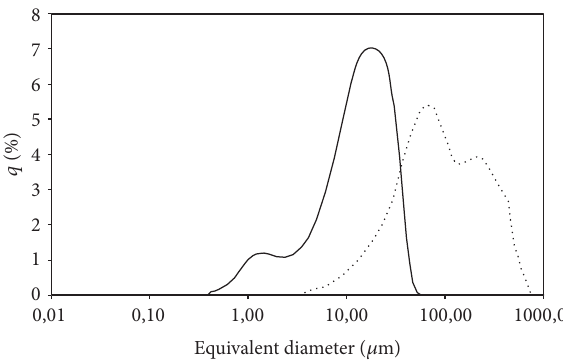
Figure 1: Particle size distribution of the fine fraction of slag (interrupted line) and CEMIIB-LL (plain